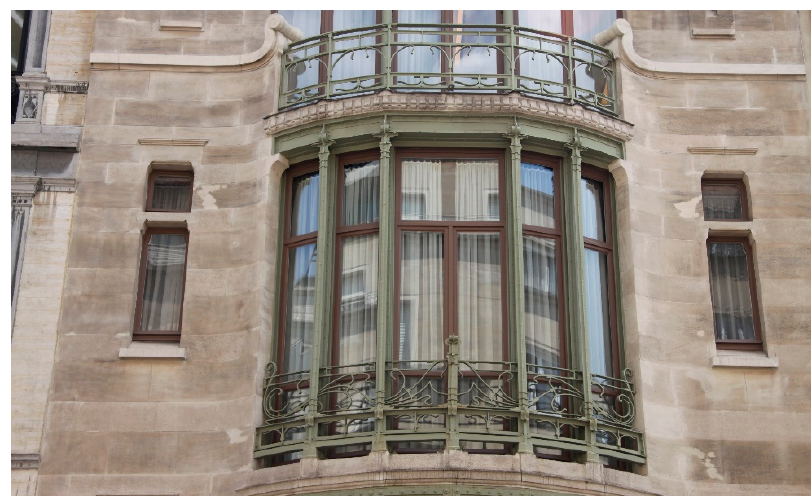
Figure 9. The green color used in the façade of the Tassel House is observed in the painted iron elements: Lintels, narrow vertical posts and a balustrade of the balcony on the second floor.